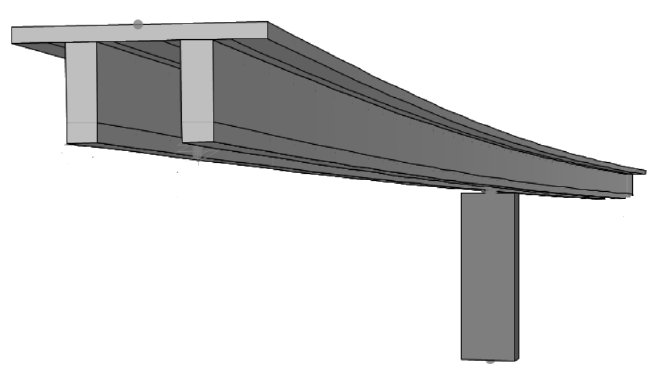
Figure 1. Numerical model of the bridge.